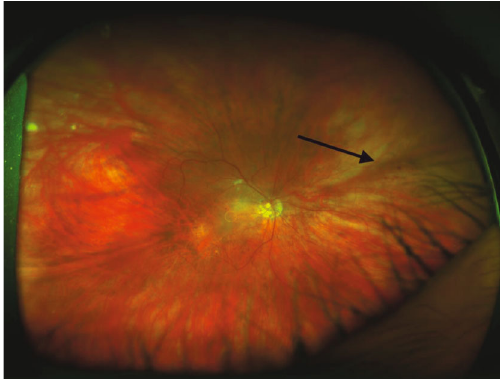
Figure 1: Optos fundus photo shows midperipheral retinal hemorrhages in the right eye.